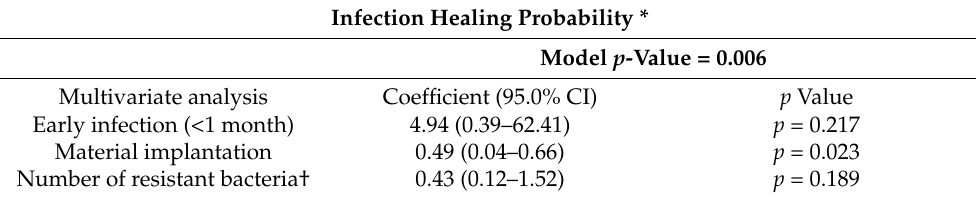
Table 5. Multivariate logistic regression model for the infection healing probability.